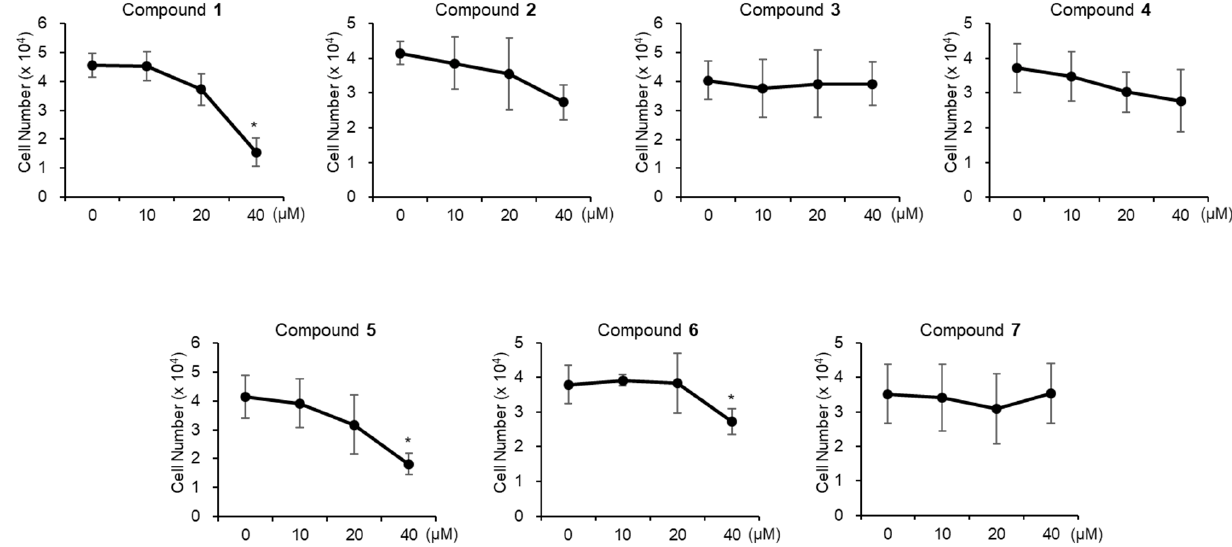
Figure 4. Cytotoxicity of compounds 1 – 7 . Viability of 3T3-L1 cells treated with compounds 1 – 7 (10, 20, and 40 µ M) for 24 h was determined by counting the cell number. The data are presented as the mean ± SD for n = 3 replicates. * p < 0.05.